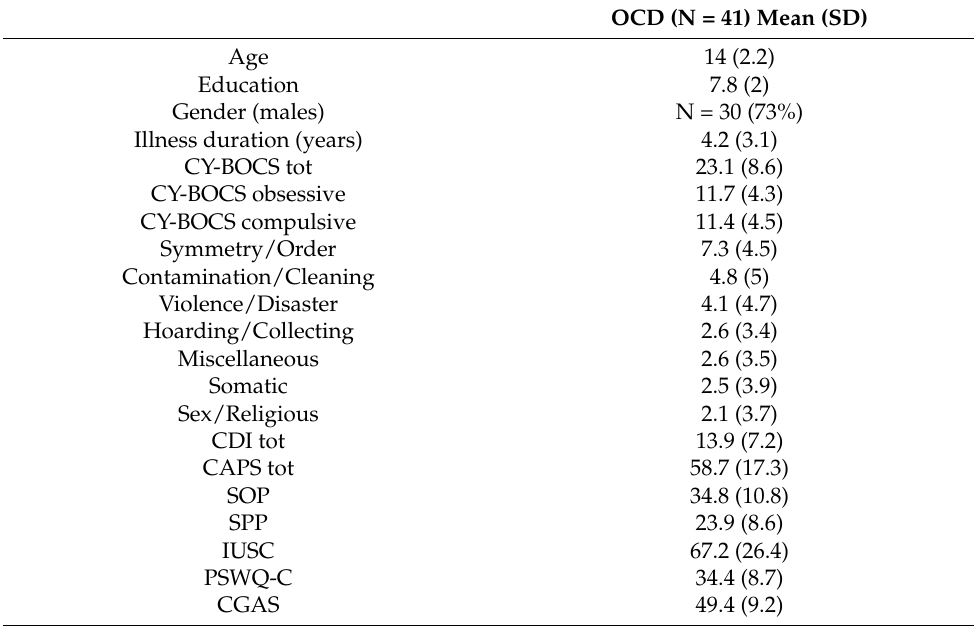
Table 1. Sociodemographic and clinical characteristics of 41 early onset OCD